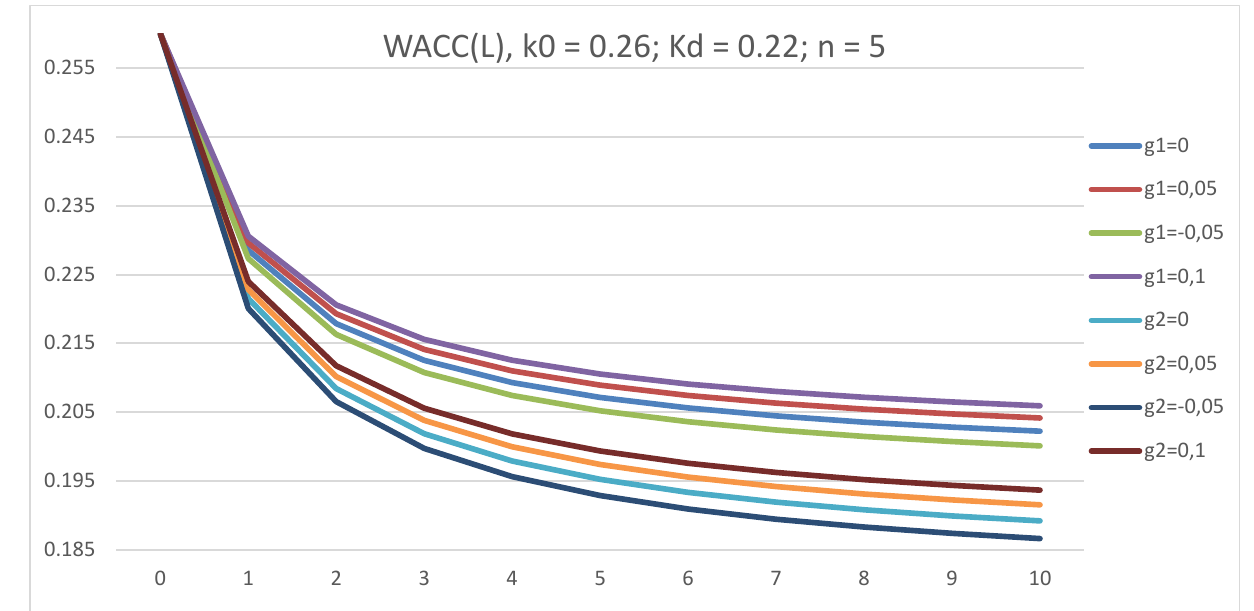
Figure 1. The dependence of WACC on leverage level L GBFO theory with payments of tax on profit at the end of periods (1) and as advance payments (2) at k 0 = 0.26; k d = 0.22; t = 0.2; g = 0.1; 0.05; 0.0; − 0.05, for a five-year company.